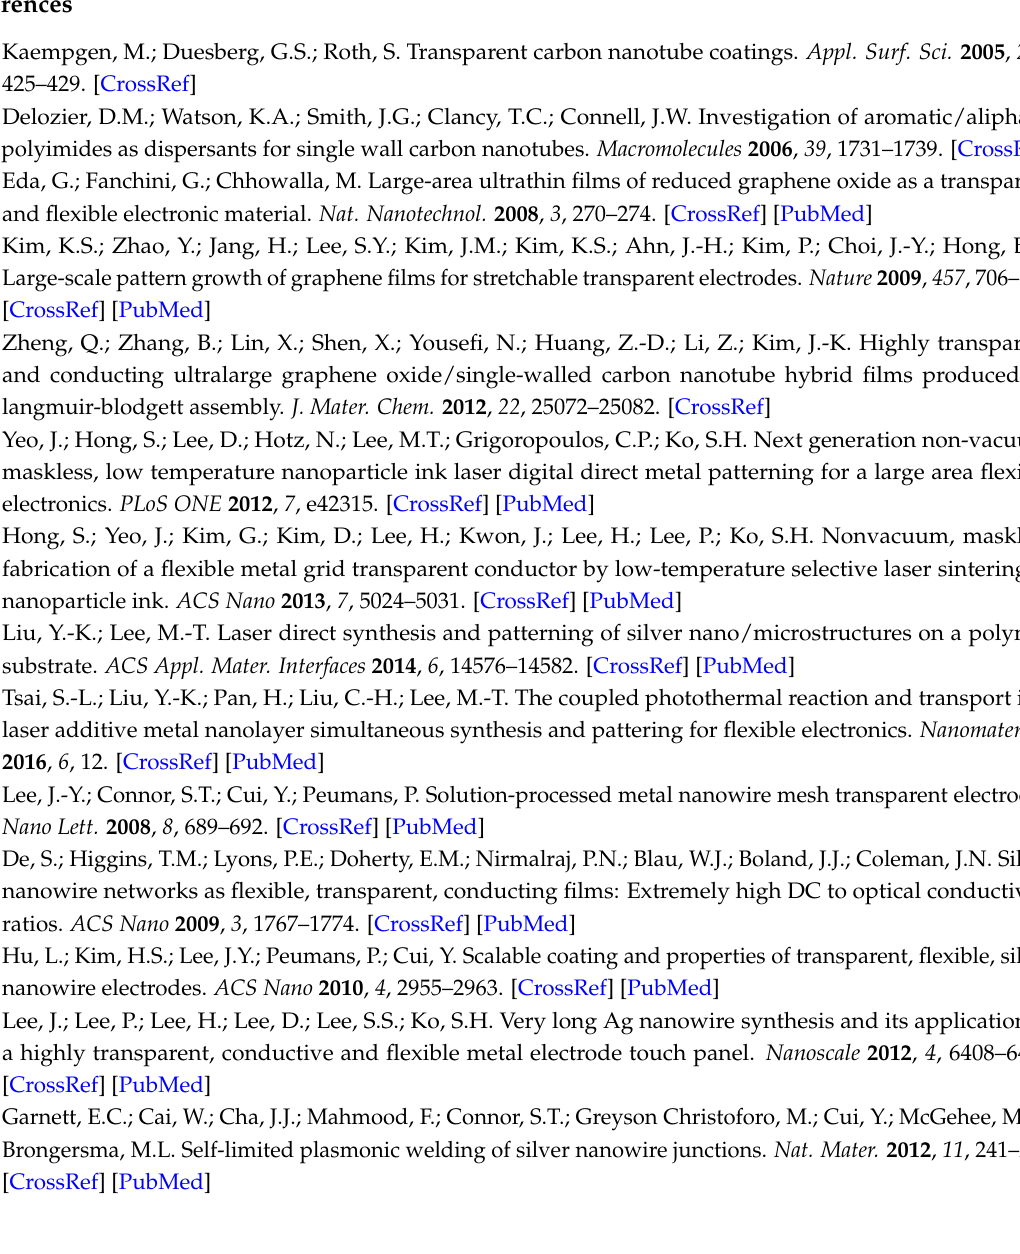
Figure S1: The sample preparation of Ag NWs percolation networks for the ns pulse (a) and cw scanning (b) LINW process. The transmittance of the sample is ~91%. Figure S2: Spatial profile of electrical field intensity and the corresponding optical power